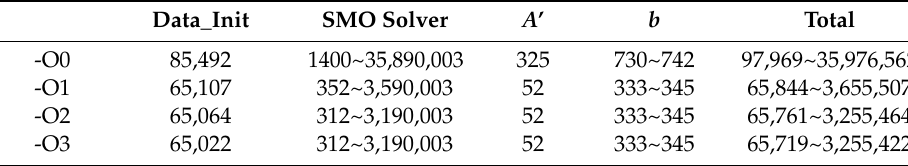
Table 3. Latency at different optimization levels.